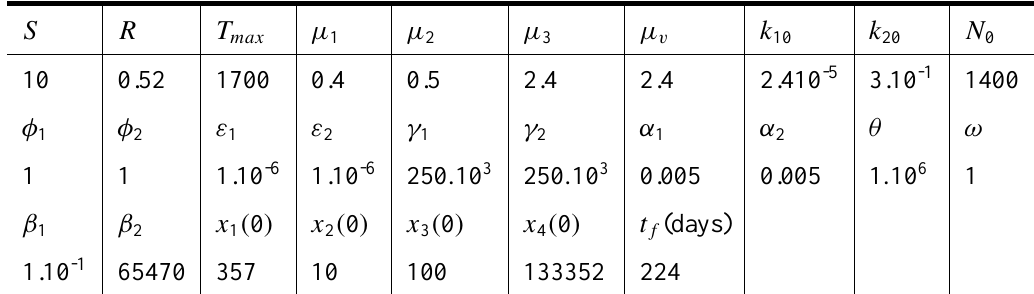
Model parameters used in the numerical